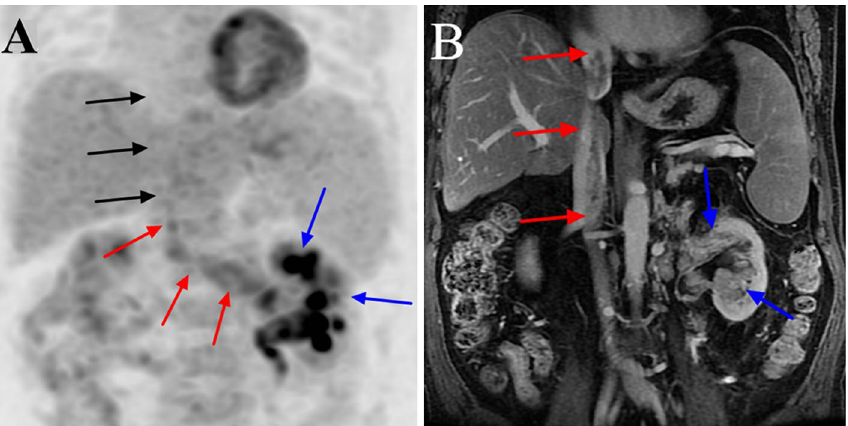
Figure 5. 18 F-FDG PET/CT and contrast-enhanced MRI (CEMRI) scans of a 62-year-old man with clear cell carcinoma of the left kidney associated with a level IV venous tumour thrombus (VTT). The VTT did not invade the venous wall and was graded as level II by PET/CT and level IV by CEMRI. The site of diffusely increased FDG uptake (SUVmax 6.3) on a PET maximum intensity projection image is the primary tumour (blue arrow) ( a ). The VTT showed pathologically increased FDG uptake (SUVmax 3.4) from the left renal vein to the inferior vena cava below the hepatic vein (red arrow) ( a ). However, there was no increased FDG uptake (SUVmax 2.0) from the hepatic vein to the inferior vena cava above the diaphragm (black arrow) ( a ). Coronal CEMRI showed that the VTT had an irregular shape, was heterogeneously enhanced, and partially occluded the vein lumen (red arrow) ( b ). The primary tumour also showed heterogeneous enhancement (blue arrow) ( a